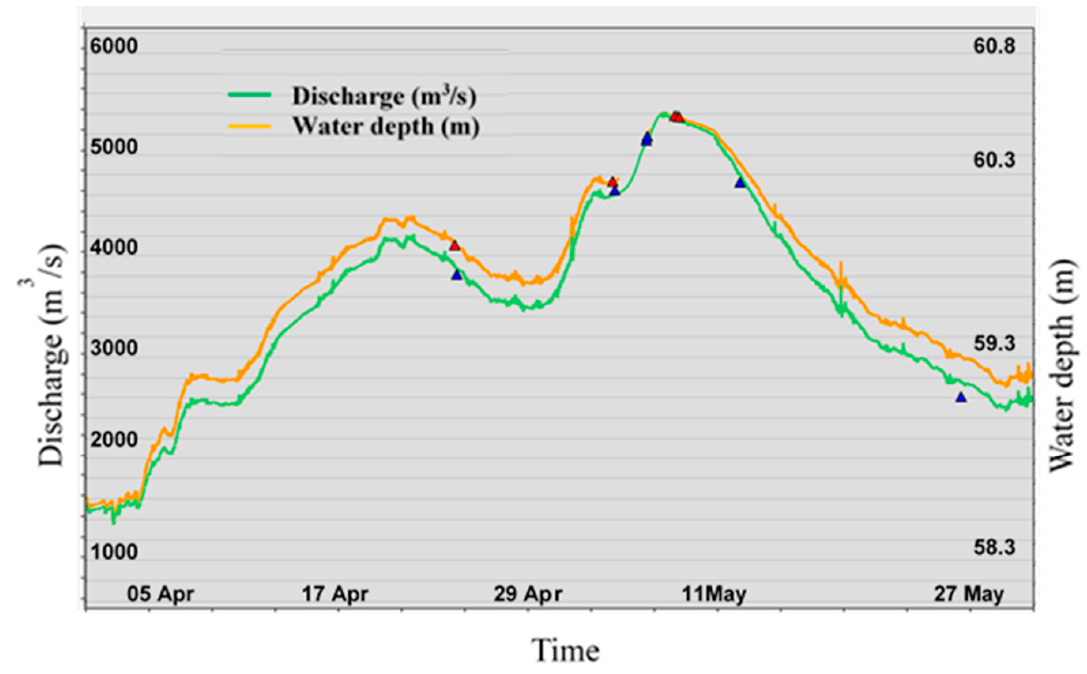
Figure 4. Discharge hydrograph observed by the Britannia (02KF005) ground station from 01 April 2017 to 31 May 2017 located downstream of the Ottawa River. The red triangles represent control measurements of water depth, and the blue triangles represent control measurements of discharge.